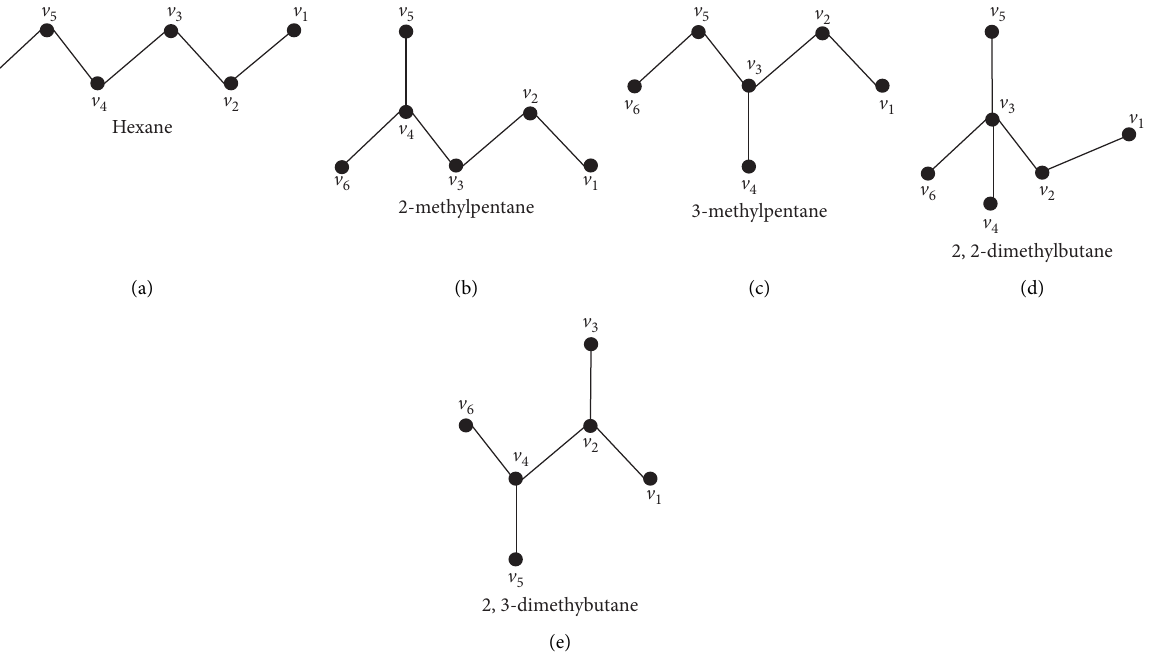
Figure 4: Molecular graphs of hexane and its isomers: (a) hexane; (b) 2-methylpentane; (c) 3-methylpentane; (d) 2,2-dimethylbutane; (e)